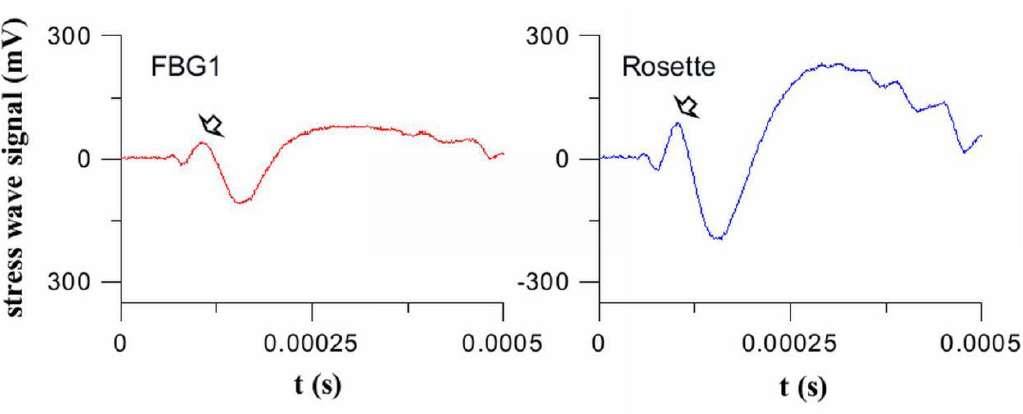
Figure 7. Signal waveforms received by Fiber Bragg grating (FBG 1) and the Type III Rosette when impact was made at r = 20 cm and θ = 45°. The peaks indicated by an arrow are used for signal strength comparison.